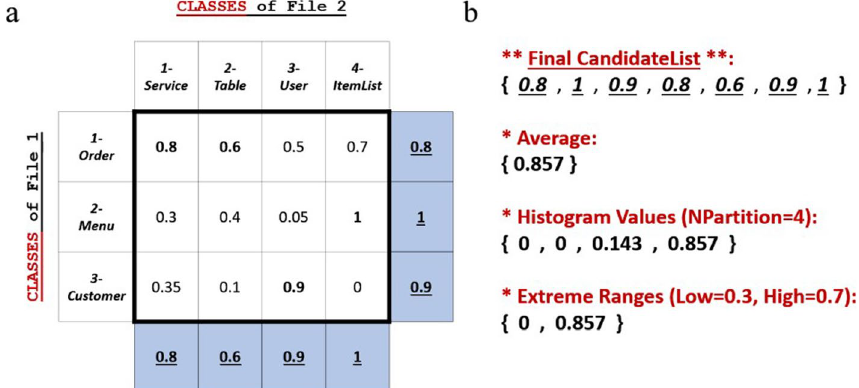
Fig. 3 a A similarity matrix. b Its candidates and